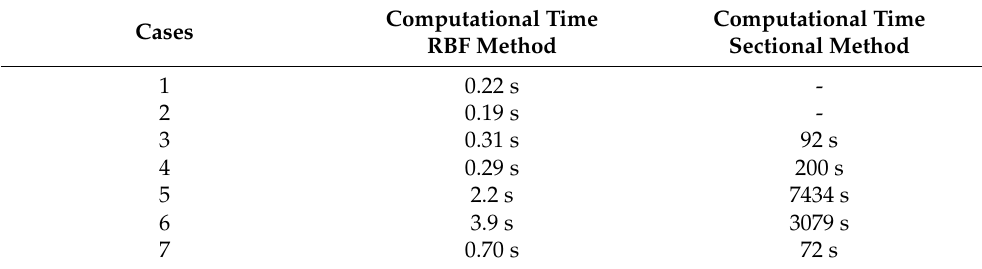
Table 3. Computational times of the RBF method and sectional method for different numerical cases.